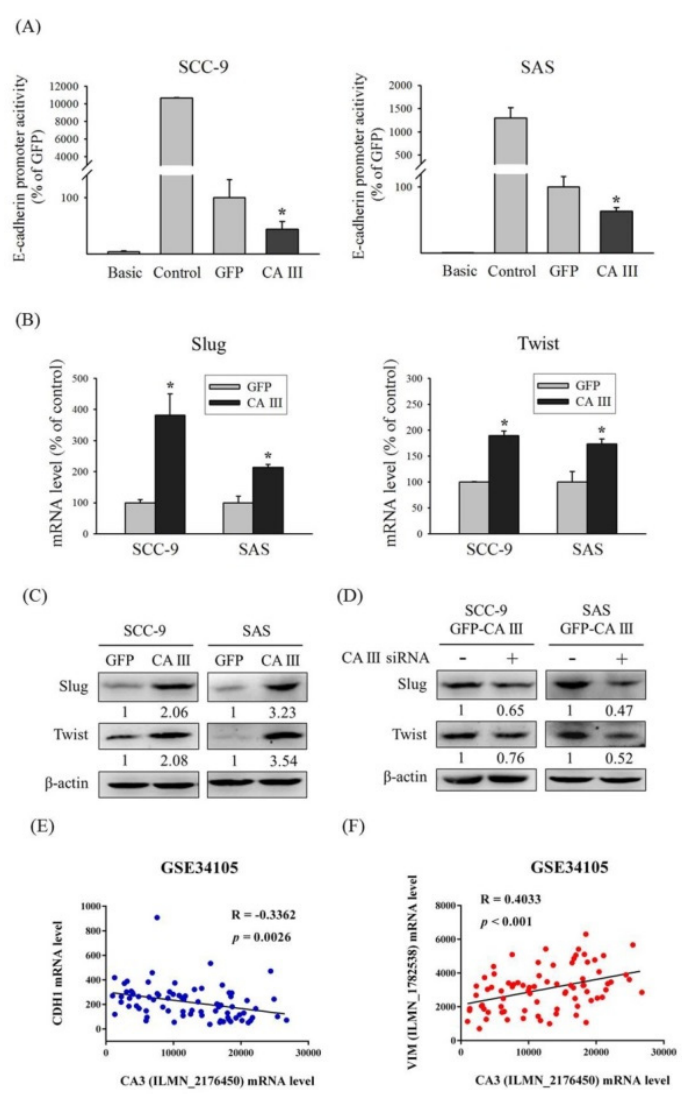
Figure 3. CA III inhibits the promoter activity of E-cadherin and promotes EMT-related transcription factors Slug and Twist in oral cancer cells. ( A ) The E-cadherin promoter activity of SCC-9 and SAS CA III stable cells. The values of luciferase activity were normalized by β -galactosidase expression. * p < 0.05 compared with the GFP. ( B ) The mRNA levels of EMT-related transcription factors Slug and Twist were analyzed by real-time PCR. The relative mRNA expression was normalized to GAPDH. * p < 0.05 compared with the GFP. ( C ) The protein expression of EMT-related transcription factors Slug and Twist was analyzed by Western blot. β -actin was used as the loading control. ( D ) The protein expression of EMT-related transcription factors Slug and Twist after transfection with scrambled siRNA or CA III siRNA in CA III stable cells. β -actin was used as the loading control. ( E ) Correlation between CA III and CDH1 mRNA expression in the oral cancer tissue from the GEO database. ( F ) Correlation between CA III and VIM mRNA expression in the oral cancer tissue from the GEO